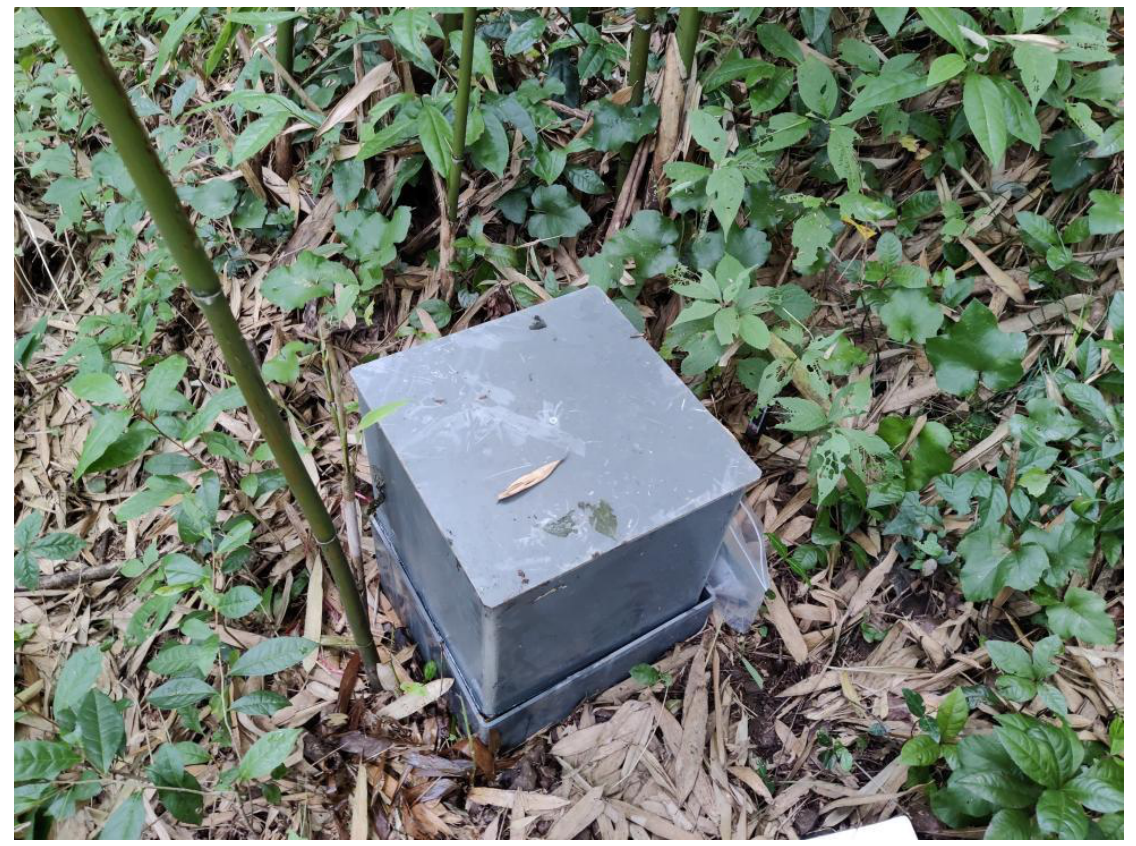
Figure 2. The static chamber for GHG flux measurement.